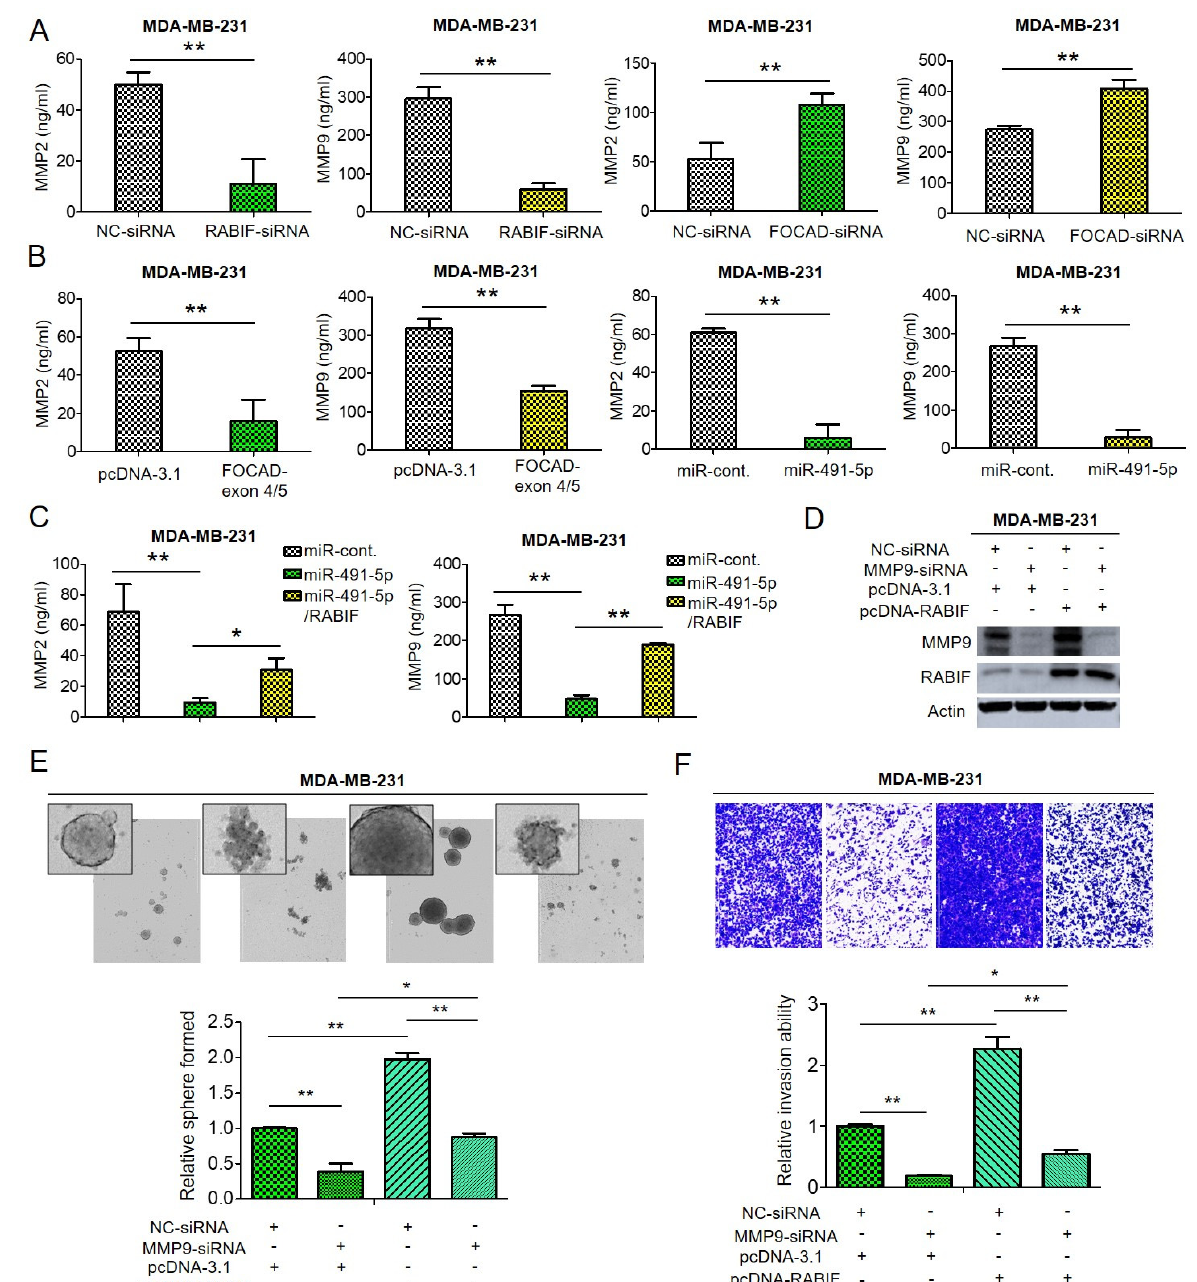
Figure 6. The effect of FOCAD/miR-491-5p/RABIF axis on the expression of MMP-2 and MMP-9. ( A ) Quantification of MMP-2 and MMP-9 levels in MDA-MB-231 cells transfected with RABIF-siRNA (left) or FOCAD-siRNA (right) measured using ELISA analysis. ( B ) The quantities of MMP-2 and MMP-9 in MDA-MB-231 cells transfected with FOCAD-exon 4/5 plasmid (left) or miR-491-5p (right) were measured by ELISA analysis. ( C ) The quantities of MMP-2 in MDA-MB-231 cells transfected with the indicated plasmids were measured by ELISA analysis. ( D ) The protein expression levels of MMP-9 and RABIF as reflected by Western blotting analysis in MDA-MB-231 cells transfected with the indicated plasmids are shown. Actin was served as an internal control. ( E ) Observations of spheres forming under stem cell selective conditions after 8 days of culturing MDA-MB-231 cells transfected with the indicated plasmids. Representative images are shown, and quantitative data are presented as histograms. ( F ) Analysis of cell invasion ability of MDA-MB-231 cells transfected with the indicated plasmids by Boyden chamber assay is shown. The representative photographs of the invaded cells from different treatments are shown as pictures and the quantitative data are shown by histograms. All histograms represent means ± s.e. from three independent experiments (* p < 0.05, ** p < 0.01). All experiments were performed in triplicates and done at least